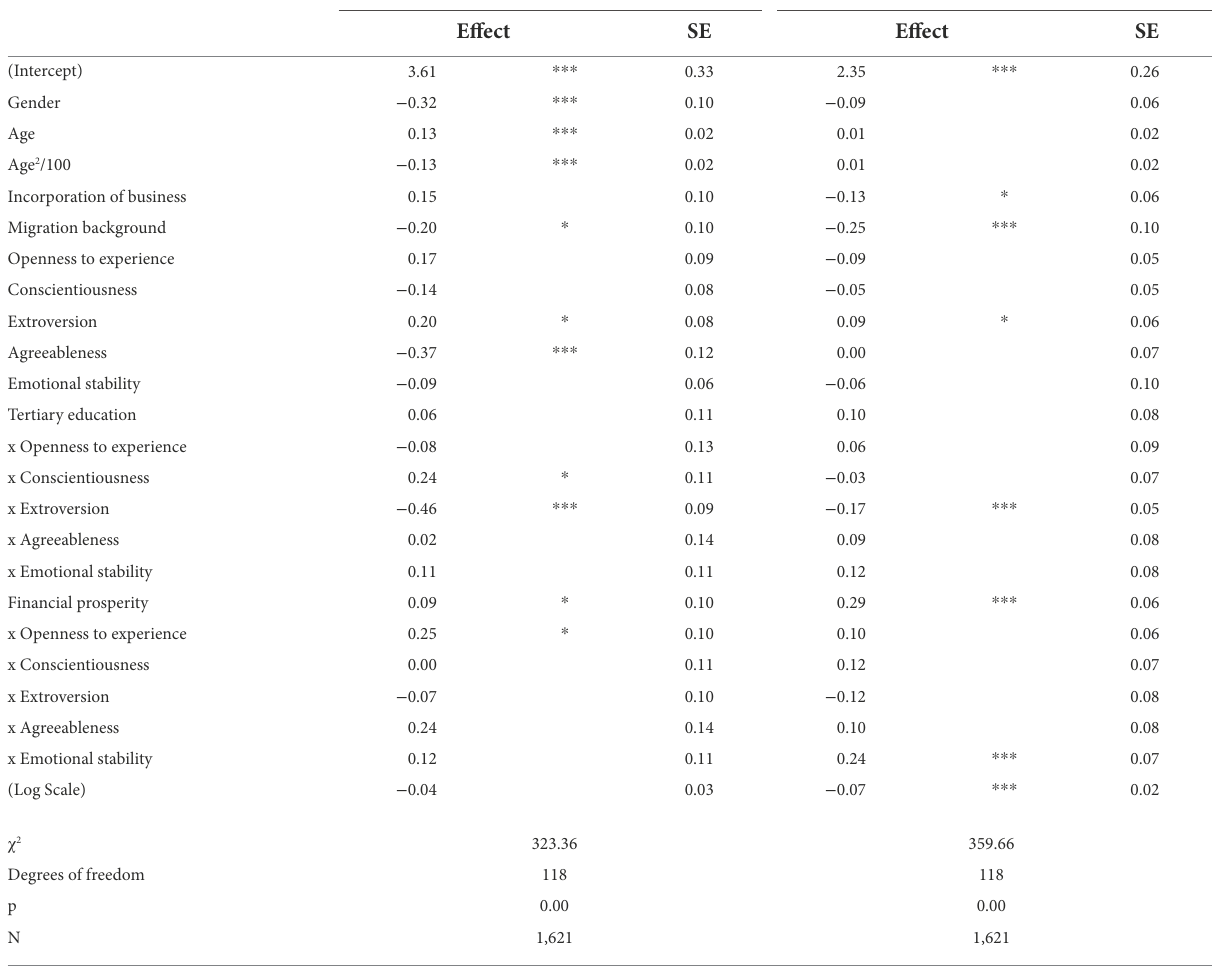
TABLE 2 Impact of the big five on self-employment survival stints (regression